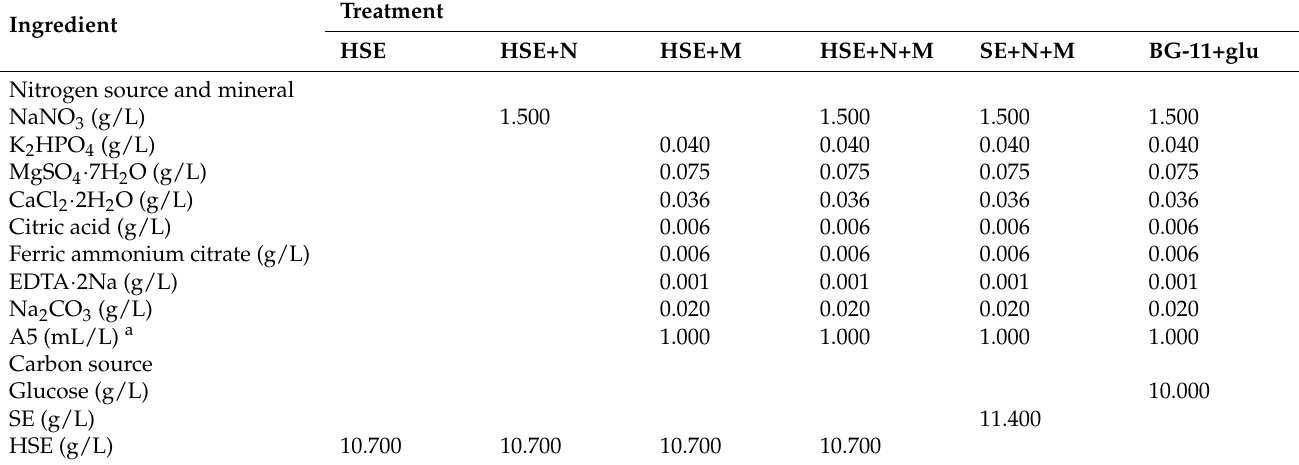
Table 1. Components of the used